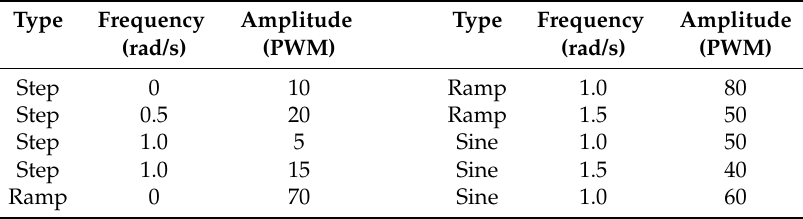
Table 1. Input datasets for the model’s parameter